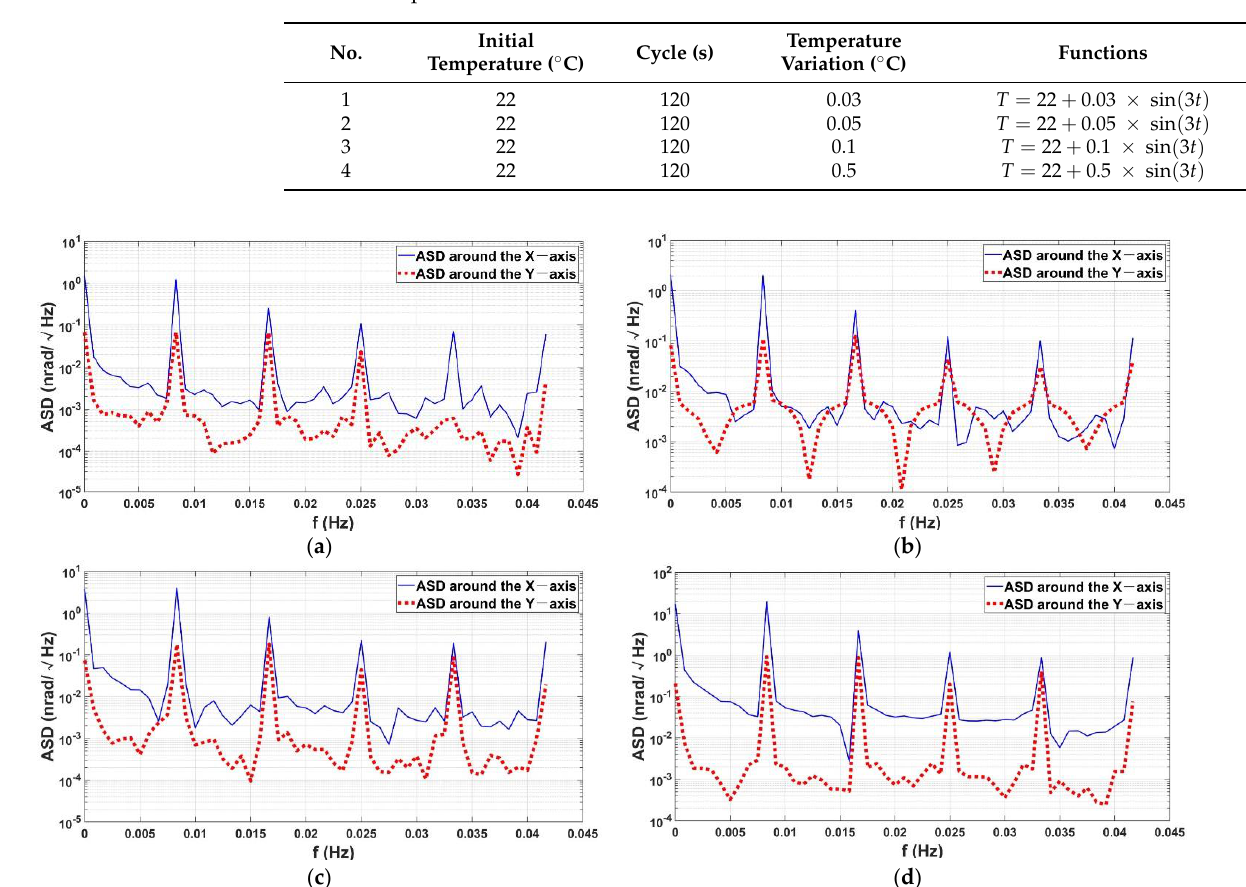
Table 5. Temperature variation functions.